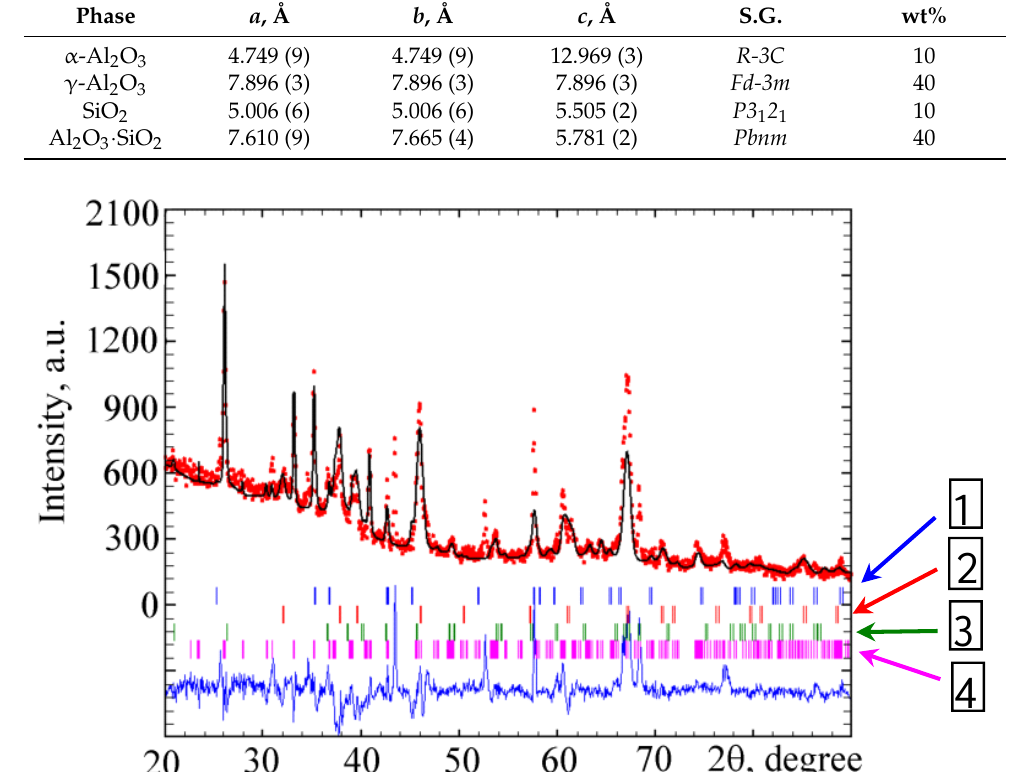
Figure 8. The observed (red dots at top), calculated (lines in the middle) and differential (blue line at the bottom) XRD patterns (in CuK α -radiation) of the PEO layer synthesized on the AK9 alloy in a weakly alkaline basic electrolyte of 3 g/L KOH + 2 g/L Na2SiO3 composition. The numbers indicate the reflections corresponding to (1) α -Al 2 O 3 , (2) γ -Al 2 O 3 , (3) SiO2 and (4) Al 2 O 3 · SiO2 phases. Table 2. Crystallographic parameters and quantitative content of phases in the PEO layer synthe- sized on the AK9 alloy in a weakly alkaline electrolyte of 3 g/L KOH + 2 g/L Na 2 SiO 3 + 3 g/L H 2 O 2 composition.